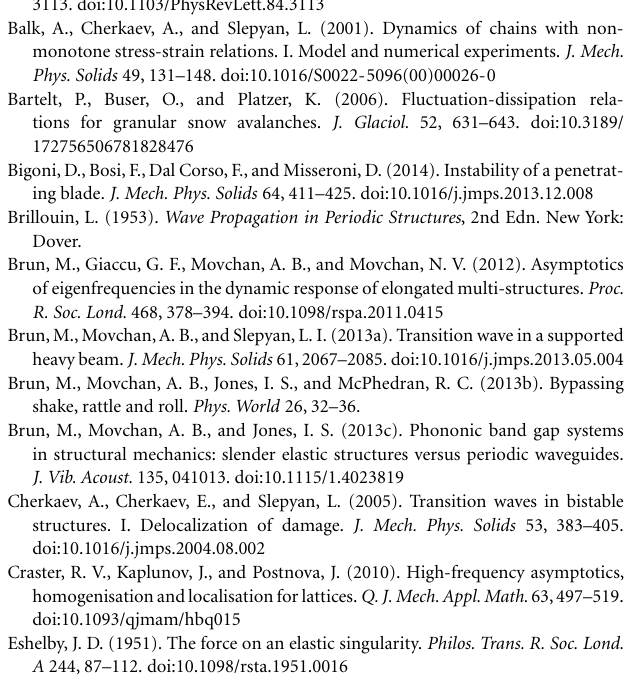
gravitational force. At steady-state regime of failure propagation, the configurational force P η = ρ gH is the energy release rate G η , independent of the velocity v